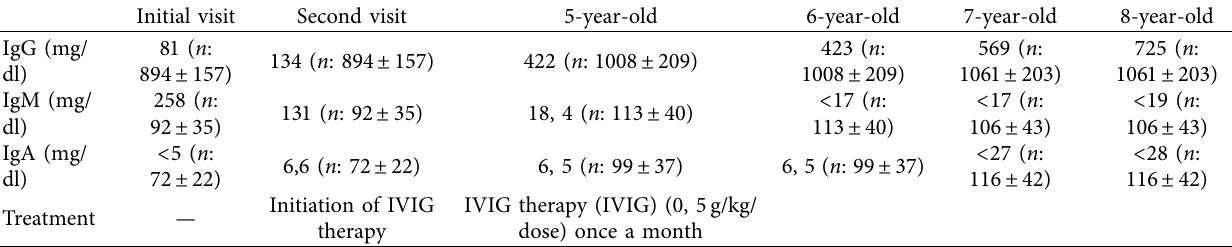
Table 3: Patient’s Ig levels by